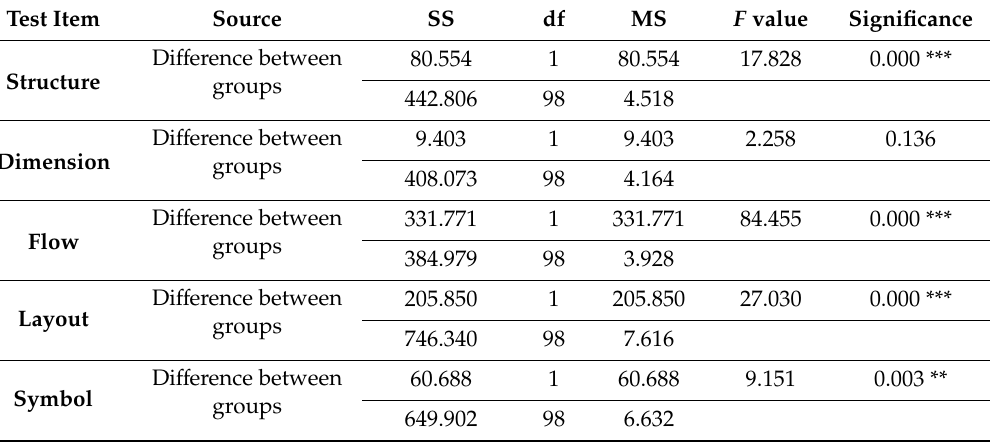
Table 5. One-way analysis of variance (ANOVA) summary table for two groups of learning